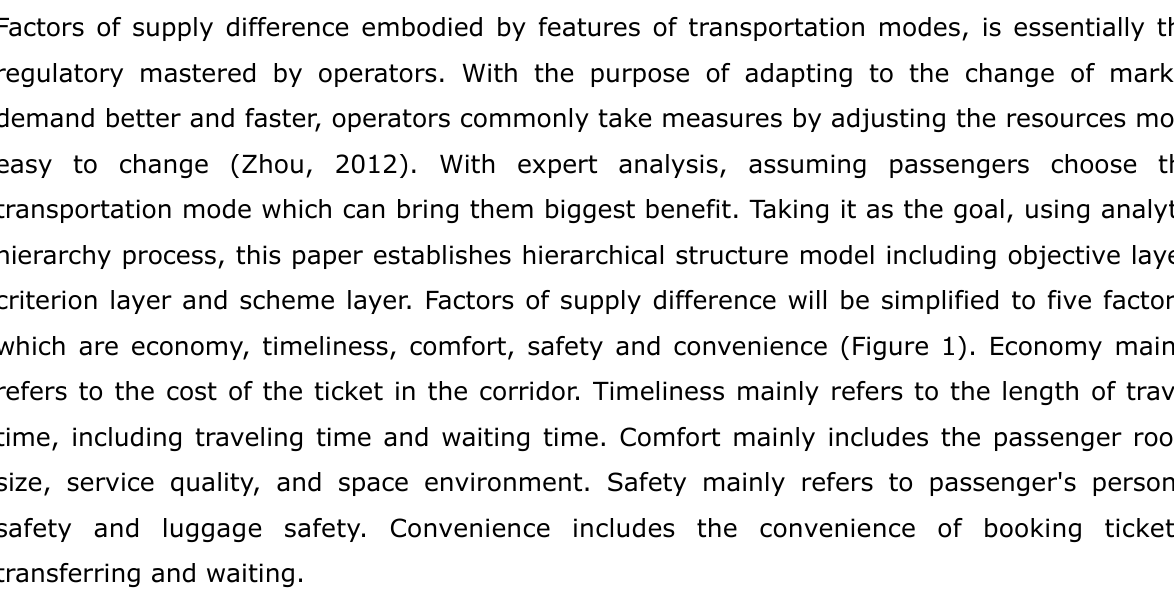
Figure 1. Hierarchical structure of passenger travel influence